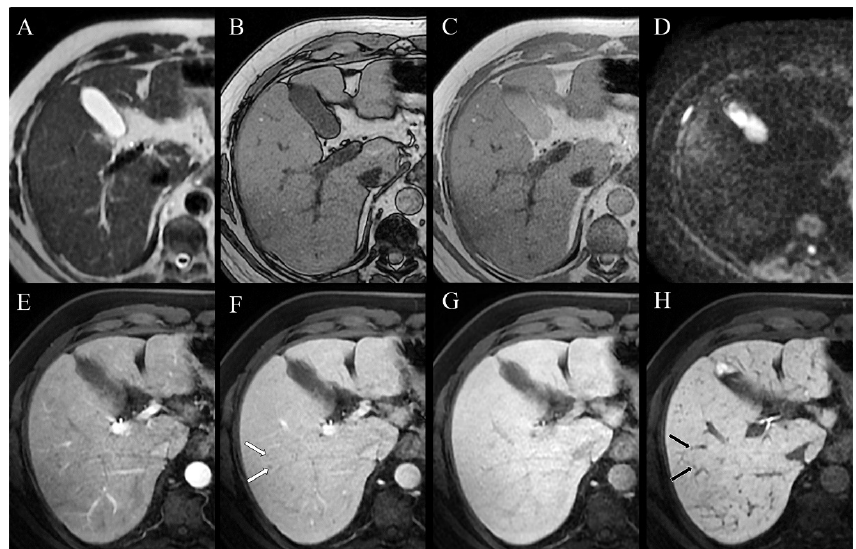
Figure 4. Abdomen magnetic resonance: ( A ) T2w, ( B ) T1w out-of-phase, ( C ) T1w in-phase, ( D ) DWI, ( E ) arterial phase, ( F ) portal venous phase, ( G ) delayed phase, and ( H ) hepatobiliary phase images. Millimeter-sized lesions spread throughout the whole liver appear hypointense in all sequences, and do not show enhancement after administration of contrast